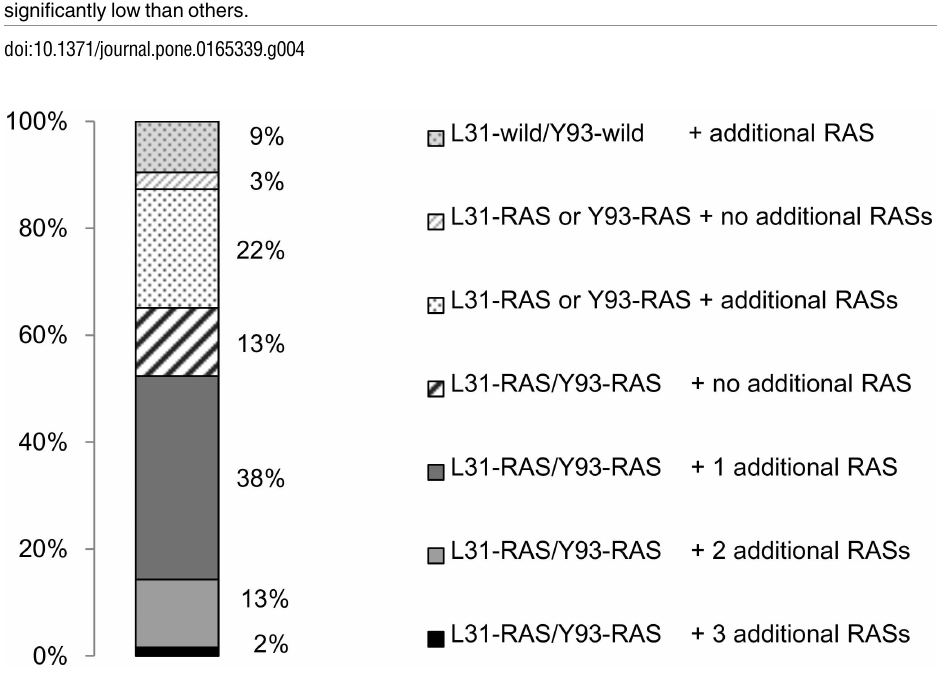
Fig 5. Prevalenceof other RASs within NS5A in combination with signature L31/Y93 RAS. Other RAS in combination with dual signature RAS (L31-RAS/Y93-RAS) were detected in 53% of patients. The prevalences of triple, quadruple, and quintuple RAS were 38%, 13%, and 2%, respectively.